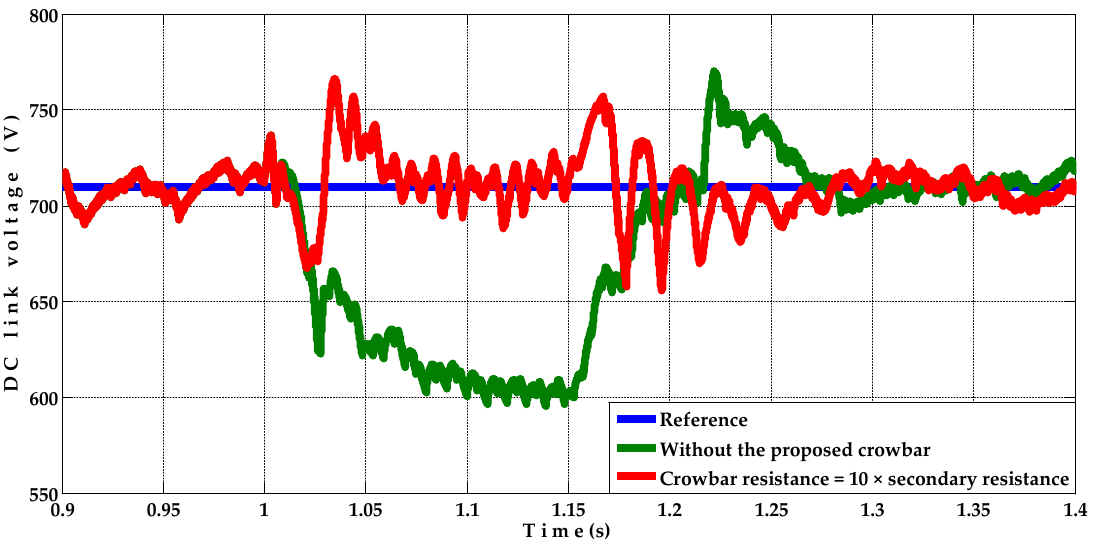
Figure 36. DC link voltage of BDFRG with and without the proposed crowbar under double line to ground fault occurrence.